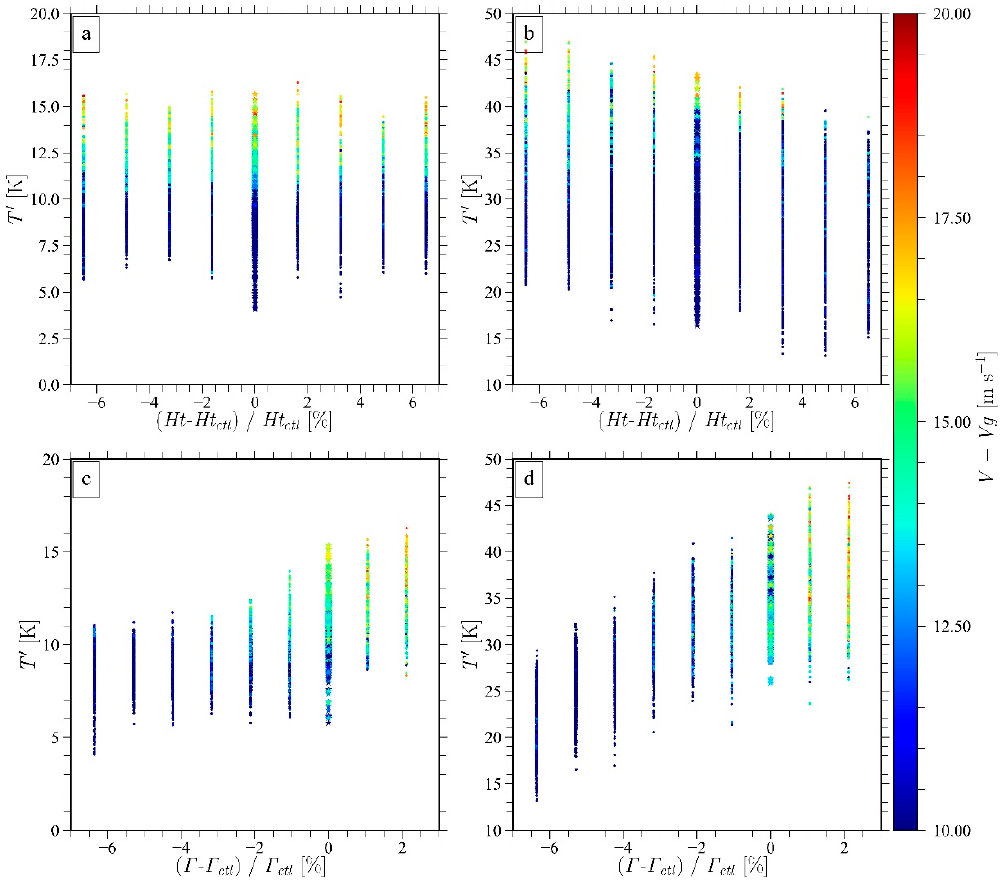
Figure 9. The relationships of the temperature anomalies of warm cores to the stability conditions. The relationships between the lower-core temperature anomaly and ( a ) H t and ( c ) Γ and between the upper-core temperature anomaly and ( b ) H t and ( d ) Γ , obtained from the result at each time step during the equilibrium state in all the experiments. The color indicates the degree of supergradient wind.